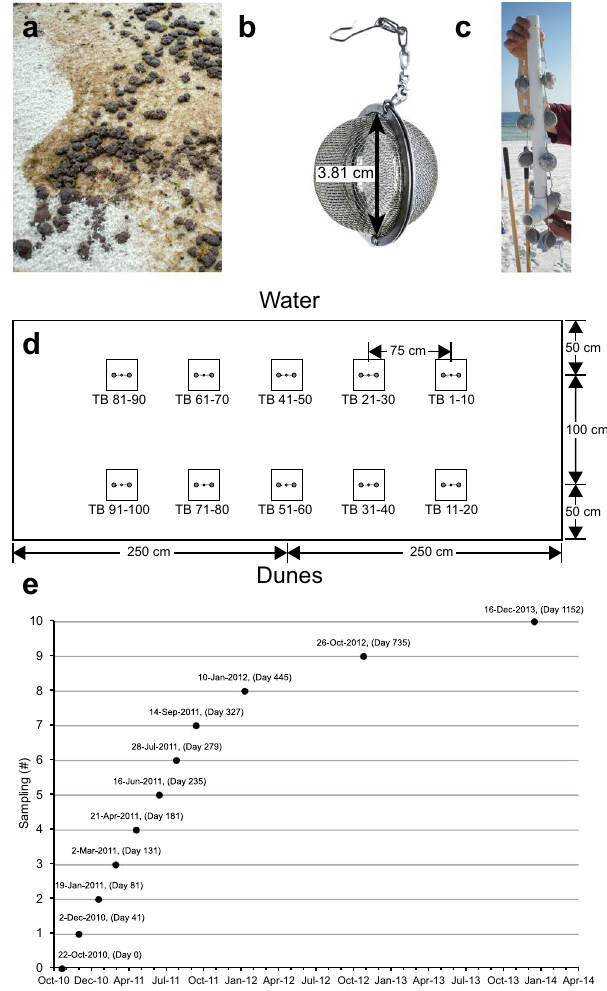
Figure 1. Preparation, burial and retrieval of the experimental sSOAs. ( a ) SOAs at Pensacola Beach that were collected to produce the homogenized oil-sand material that was filled into stainless steel tea balls like the one shown in ( b ) The tea ball could be opened for filling, and a chain attached to its solid metal flanges permitted attaching the filled tea ball to the PVC pipe. ( c ) Array of 10 sSOA-filled mesh balls attached to the PVC pipe prior to burial. ( d ) Dimensions of the burial plot and locations of the sites, where the individual arrays were buried. ( e ) Time line of the experiment: Initial installation of sSOAs and sSRBs was in October 2010. sSOA arrays were retrieved from December 2010 to December 2013, (2 Dec10, 19 Jan 11, 2 Mar 11, 21 Apr 11, 16 Jun 11, 28 Jul 11, 14 Sep 11, 10 Jan 12, 26 Oct 12, 16 Dec 13), sSRBs in April 2011 and July 2011. Days elapsed are shown in parentheses as “Day